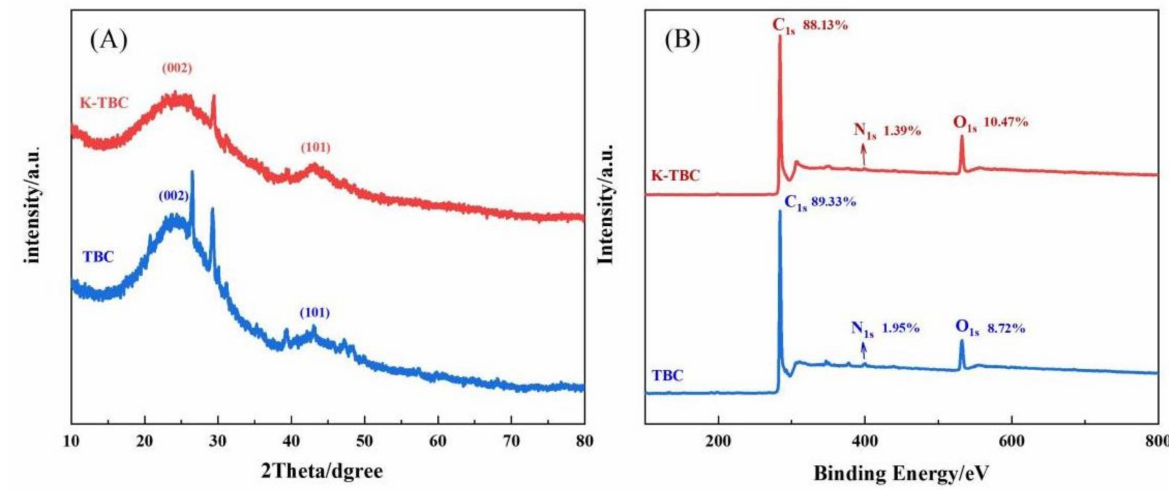
Figure 3. ( A ) XRD patterns and ( B ) The wide XPS survey spectra of K-TBC and TBC.